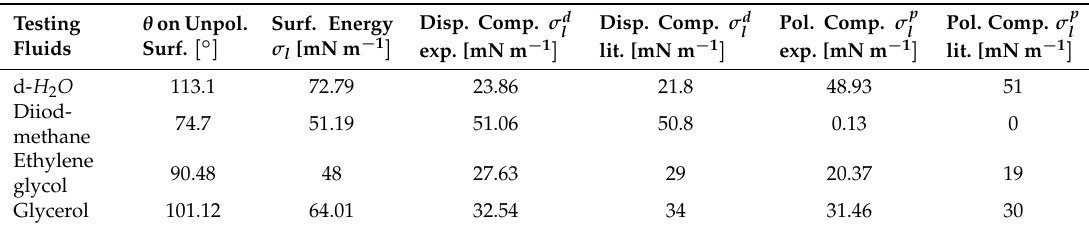
Table 3. Comparison of calculated surface energy components from testing fluids with values known from literature